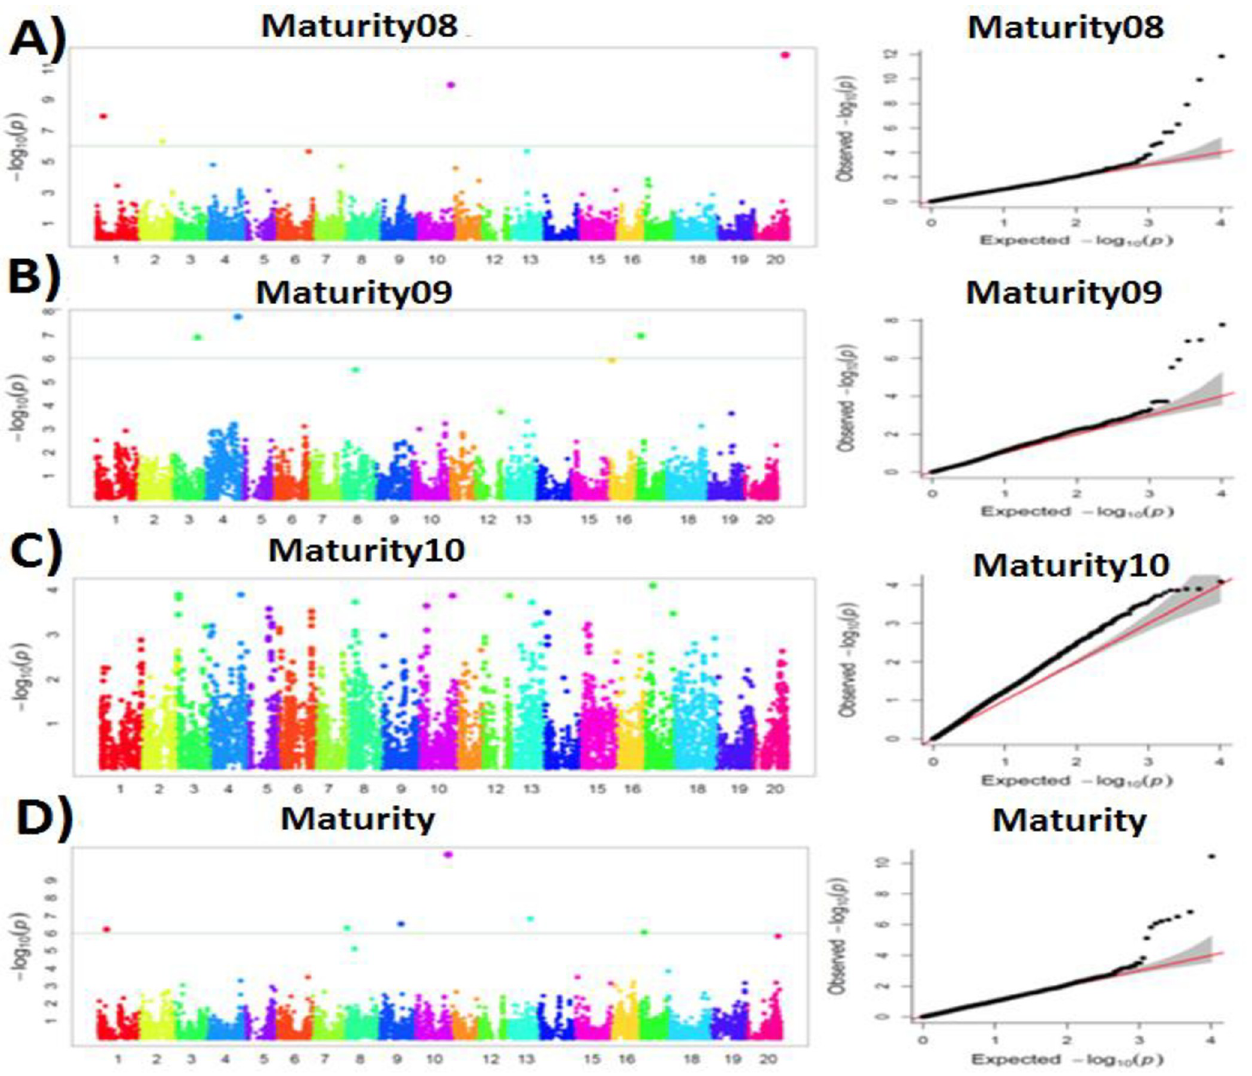
Fig 1. Manhattan plots and QQ-plots for maturity in 2008 (A), 2009 (B), 2010 (C), and the average data over 3 years